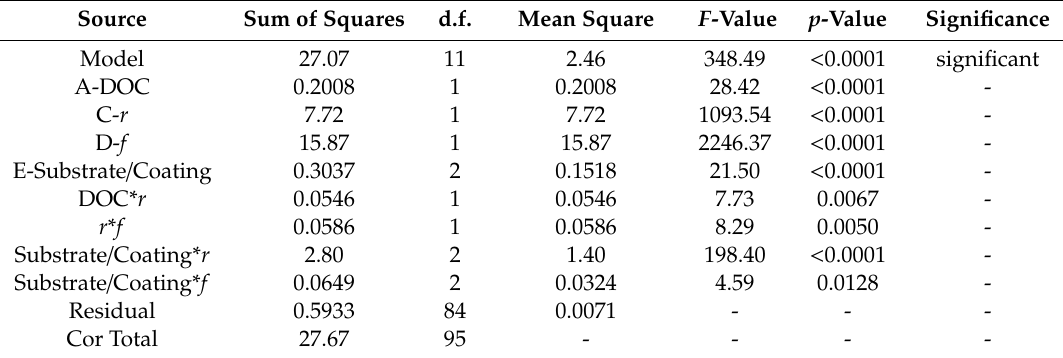
Table 7. ANOVA for reduced 2FI model of the Ra response.